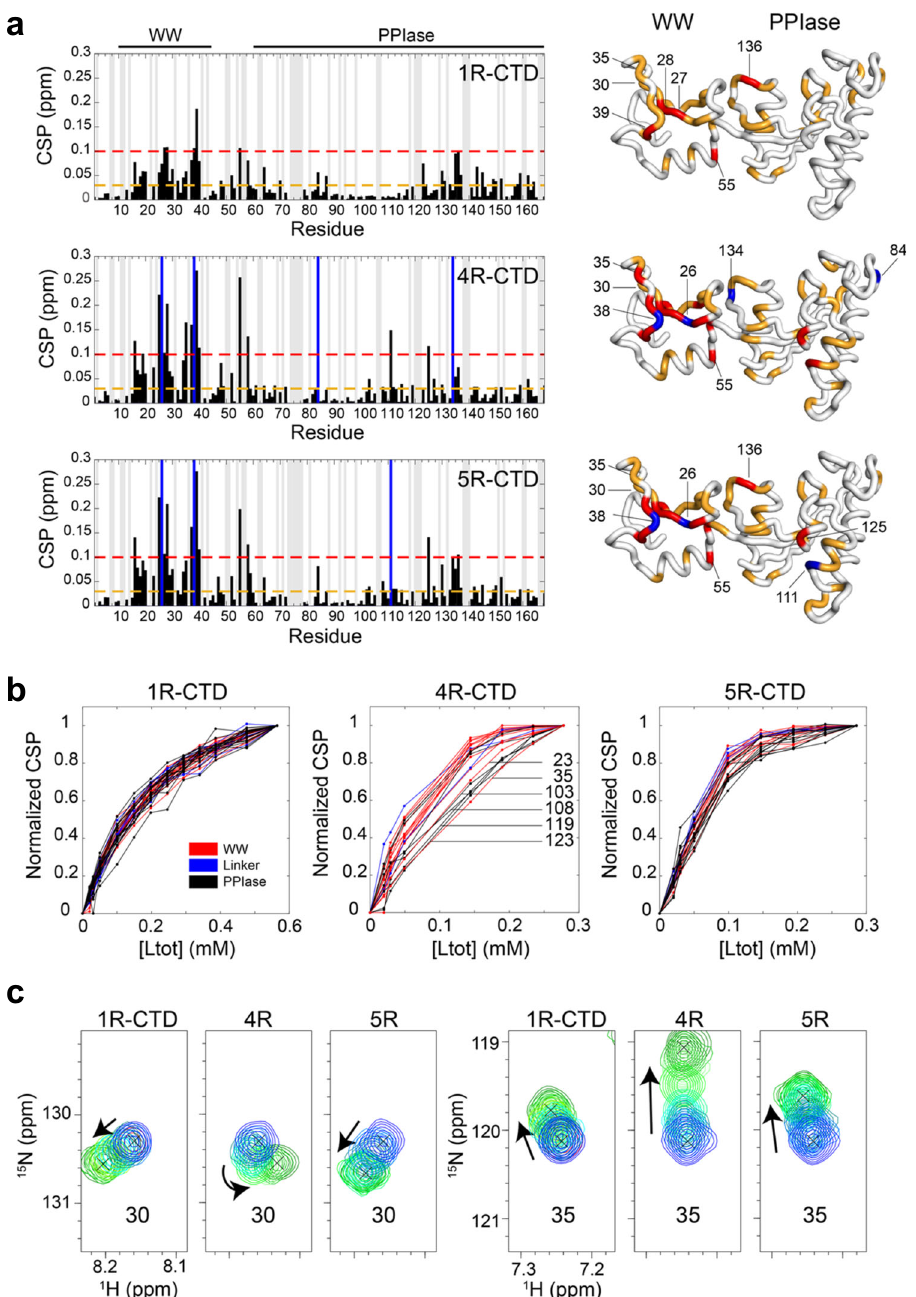
Fig. 5 NMR chemical shift data reveal simultaneous binding on long CTD peptides. a 1 H – 15 N chemical shift perturbations (CSPs) in Ess1 upon binding 1R, 4R, or 5R-CTD peptide at 2:1 peptide:protein stoichiometric ratios (4:1 for 1R-CTD). Since the 1R-CTD has only one binding site, whereas 4R and 5R each have two binding sites, we plot 1R-CTD CSPs at double the stoichiometric ratio as the other CTDs. (Right) CSPs are mapped onto the structure of Ess1, and color-coded orange and red for CSPs > 0.03 and 0.1 ppm, respectively. Residues highlighted in blue are those amide resonances that were broadened beyond detection. Gray bars indicate those resonances for which assignments were ambiguous and therefore not analyzed for CSP plots. b Normalized titration curves of Ess1 residues as unlabeled CTD peptide was added (Ltot = total concentration of ligand). Residues are color-coded indicating where the residue is located in Ess1: red (WW), blue (linker), and black (PPIase). c Chemical shift trajectories for WW residues 30 and 35 following titration with 1R, 4R, and 5R CTD peptides (see the “ Methods ”